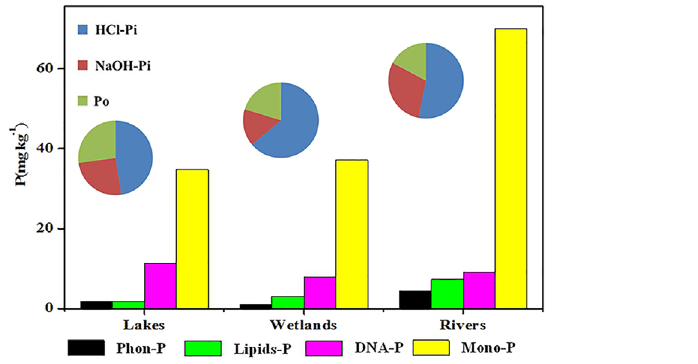
Fig 6. P components in surface sediment determined by SMT fractionation and 31 P-NMR. DNA-P: deoxyribonucleic acids (orthophosphate diesters); Lipids-P: phospholipids (orthophosphate diesters); Mono- P: orthophosphate monoesters; Ortho-P: orthophosphate; Phon-P: phosphonates; Pyro-P: